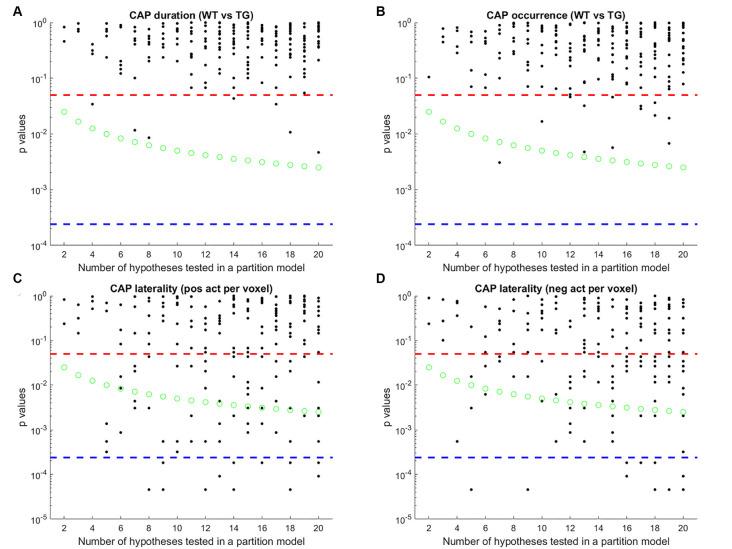
P-values of comparison of median duration (A) occurrence rate (B) laterality of average positive activation per voxel (C) and, laterality of average negative activation per voxel (D) between WT and TG groups for each CAP in each partition with the number of clusters ranging from 2 to 20. Here, CAPs are extracted from the group-level image-series. Each black marker represents a CAP. The red dashed line represents a p-value of 0.05, uncorrected. The green marker represents Bonferroni corrected threshold p-value for each partition (0.05/# of clusters within the partition). The blue dashed line represents the Bonferroni corrected threshold p-value across partitions (0.05/# of clusters across all partitions) and corresponds to the case when all hypotheses are independent across models. Here, since the same image-series is partitioned into different numbers of clusters, spatially similar CAPs can be found, and hence the hypotheses are not necessarily independent, across partitions. Therefore, we corrected for the # of comparisons within each partition in selecting CAPs for which WT-TG difference of median values was statistically significant (all black markers close to or below green circles) and then grouped them, based on spatial similarity, into prototypical patterns (Figure 6) that show robust WT-TG difference across multiple partitions.